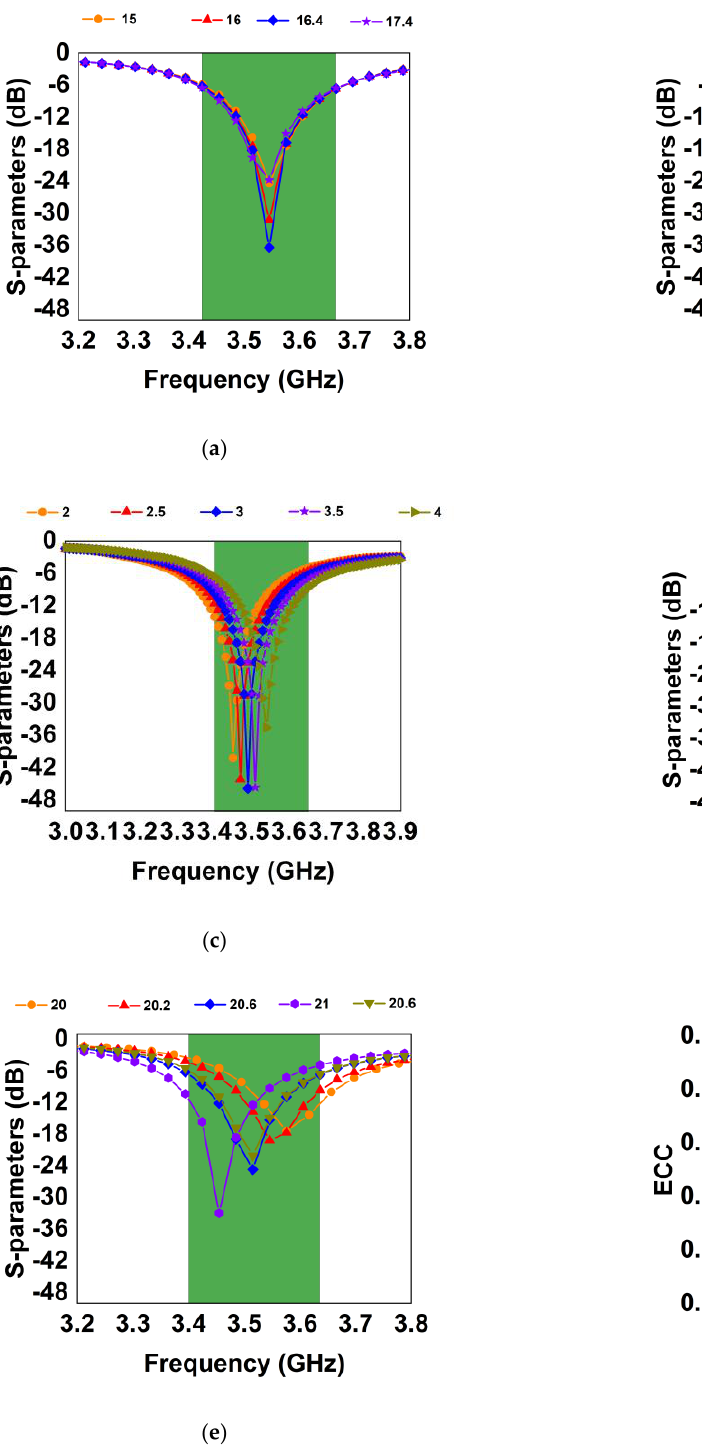
Figure 5. Scattering parameter plots ( a ) parametric study of the parameter L ( b ) parametric study of t parameter ( c ) parametric study of d parameter ( d ) parametric study of g parameter ( e ) parametric study of I parameter ( f ) envelope correlation coefficient.